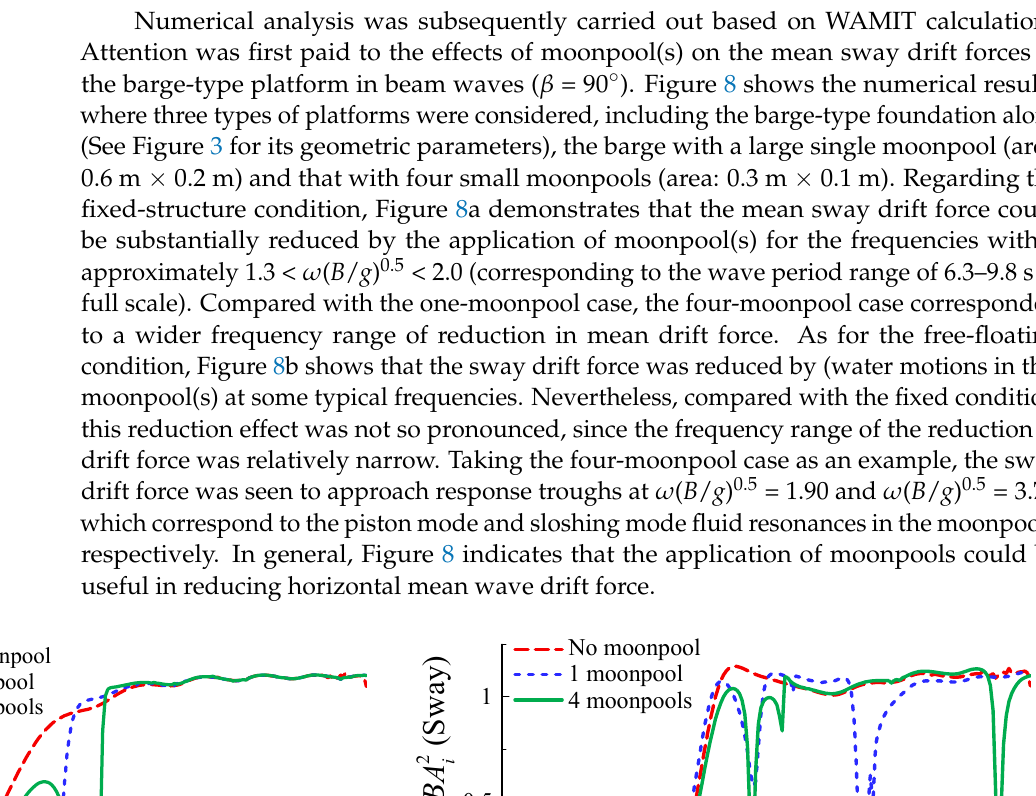
Figure 7. Measured and calculated mean sway drift forces on the floating wind turbine with four moonpools in beam waves ( V R is the rotating speed of wind turbine).